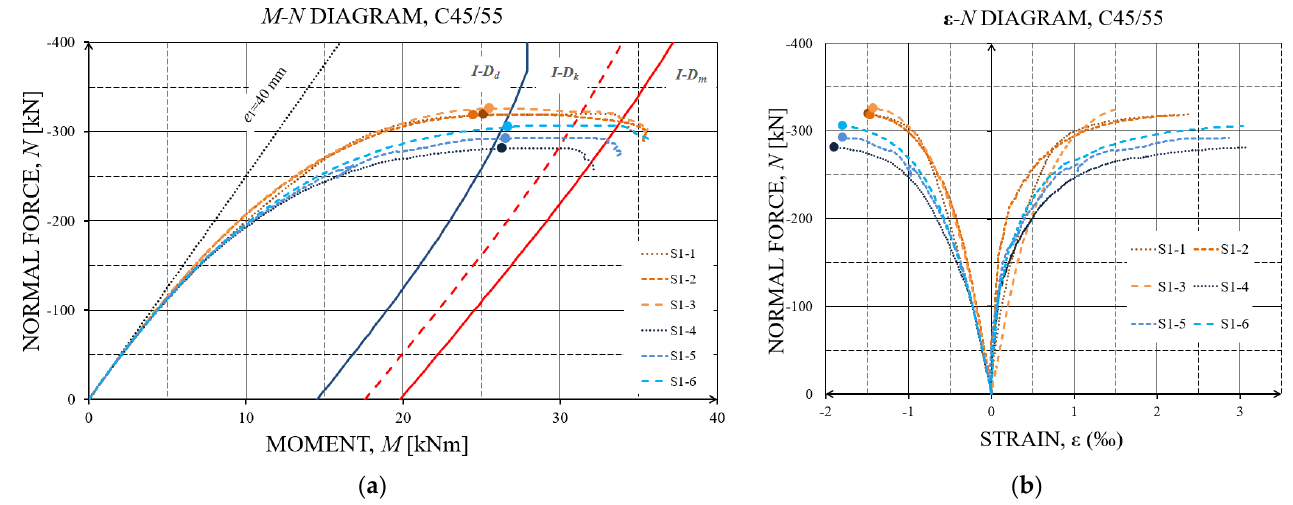
( a ) ( b ) Figure 6. Experimentally determined N-M gradients vs. the Eurocode I-D (blue graph = design values, red dashed graph = characteristic values, red graph = mean values) ( a ) and normal force — strain ( b ) of the specimens S1-1 to S1-6 [5,6]. Table 1. List of parameters used in the calculation.